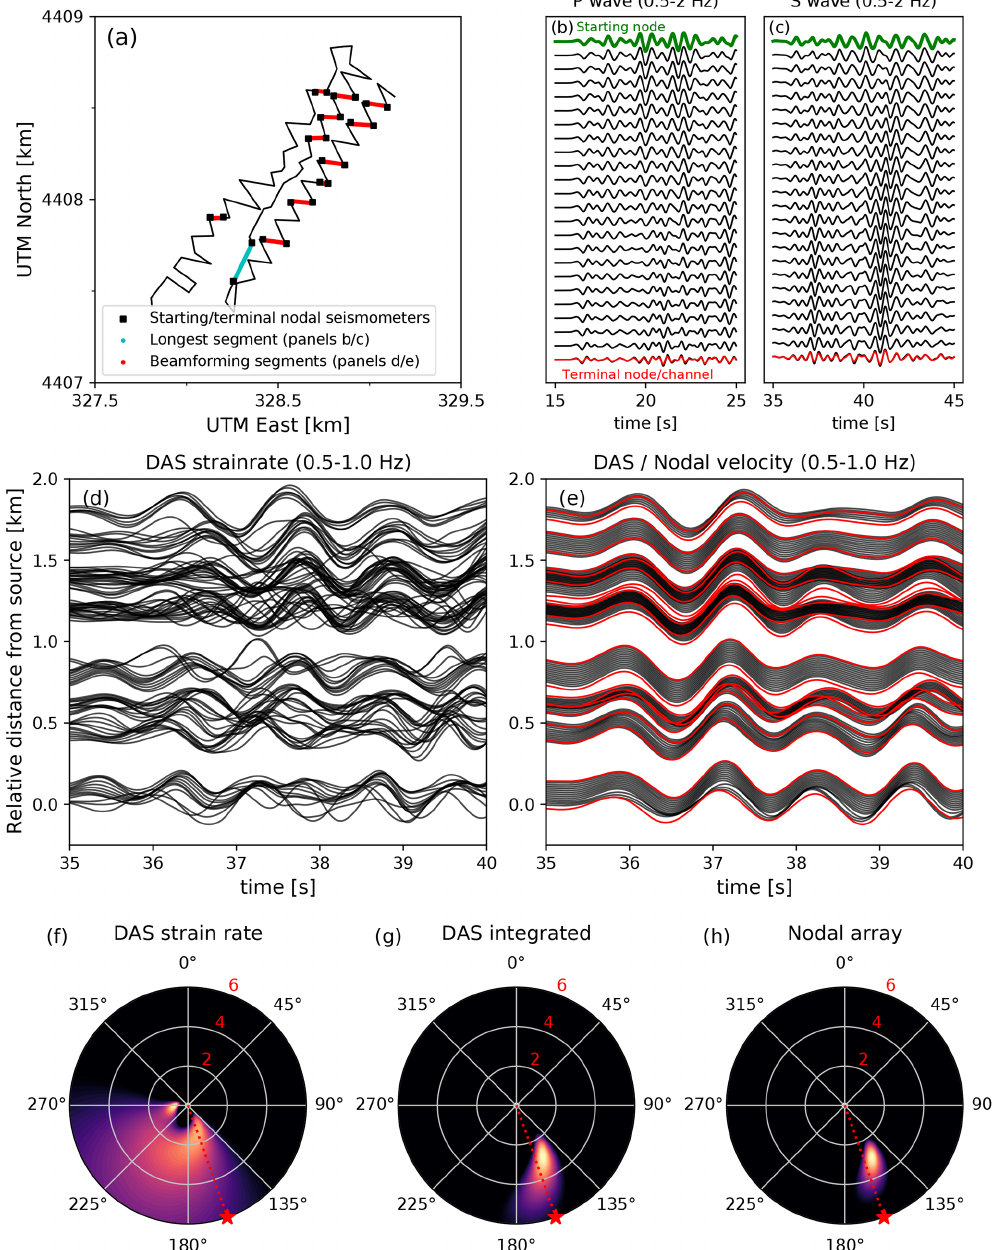
Figure 13. (a) Locations of the east–west segments in the DAS array selected for the beamforming analysis (indicated in red) along with the starting and terminal nodal seismometers. The longest quasi-linear segment of the array is indicated in cyan, (b) particle velocity P waveforms resulting from the integration of the recorded strain rates, taking the nodal seismometer waveform (green) as the starting point. The terminal node waveform (red) is plotted on top of the last DAS channel for a direct comparison; (c) same as in panel (b) , but for the S wave; (d) DAS strain rates measured along the selected segments (see panel a ); (e) particle velocities as resulting from the integration of DAS strain rates (in black), and as recorded by the starting/terminal nodal seismometers (in red); (f–h) beamforming results for the DAS strain rates, converted particle velocities, and nodal seismometer recordings, respectively. The waveforms used are as shown in panels (d) and (e) (first 5s of the S wave, 0.5–1Hz frequency band). The radial increments are indicated in kms − 1